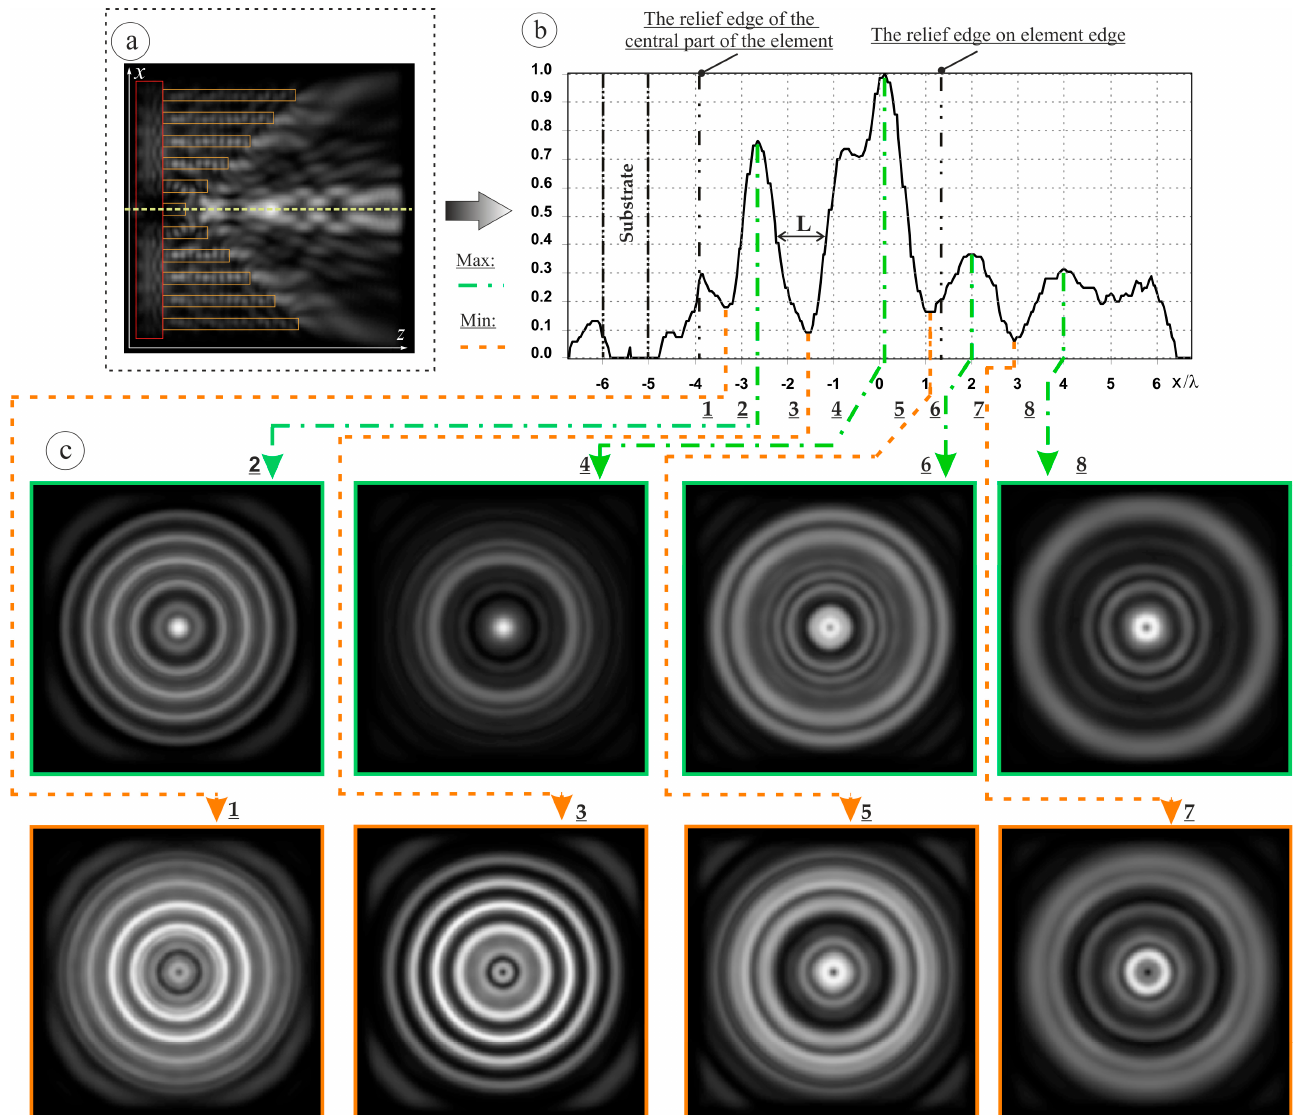
Figure 10. Two-dimensional diffraction pattern of the Laguerre–Gaussian mode (1,0) (see Figure 9a,b): ( a ) xz plane, ( b ) cross section in the xz plane, and ( c ) cross sections in the xy plane.